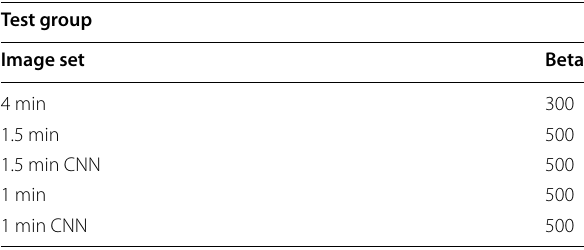
Table 2 Overview of the whole-body image sets in the test